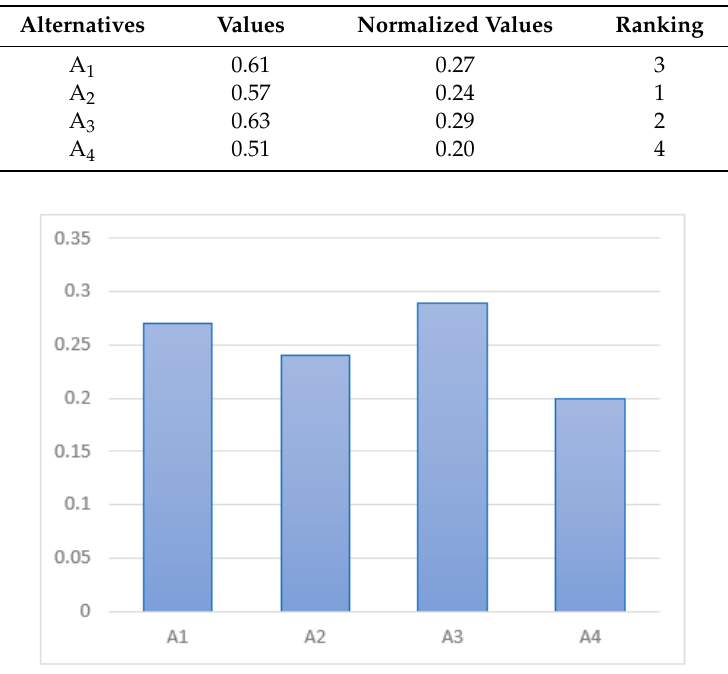
Figure 10. Final ranking using the MOORA method. Figure 11. Final ranking using the MOORA